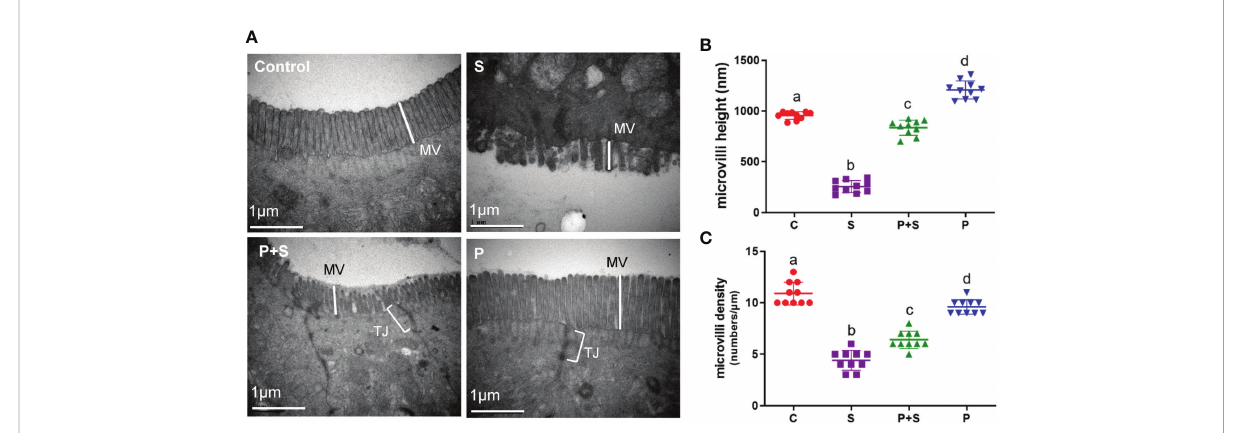
FIGURE 3 The structural damage in intestinal microvilli and microvilli length and density changes. (A) The effects of different treatments on microvilli (MV) structure and tight junction (TJ) protein in the chicken intestinal tract were observed under a transmission electron microscope (TEM). (B, C) The length and density of microvilli were measured. a, b, c, d: indicated the same item with different letters differ signi fi cantly ( P <